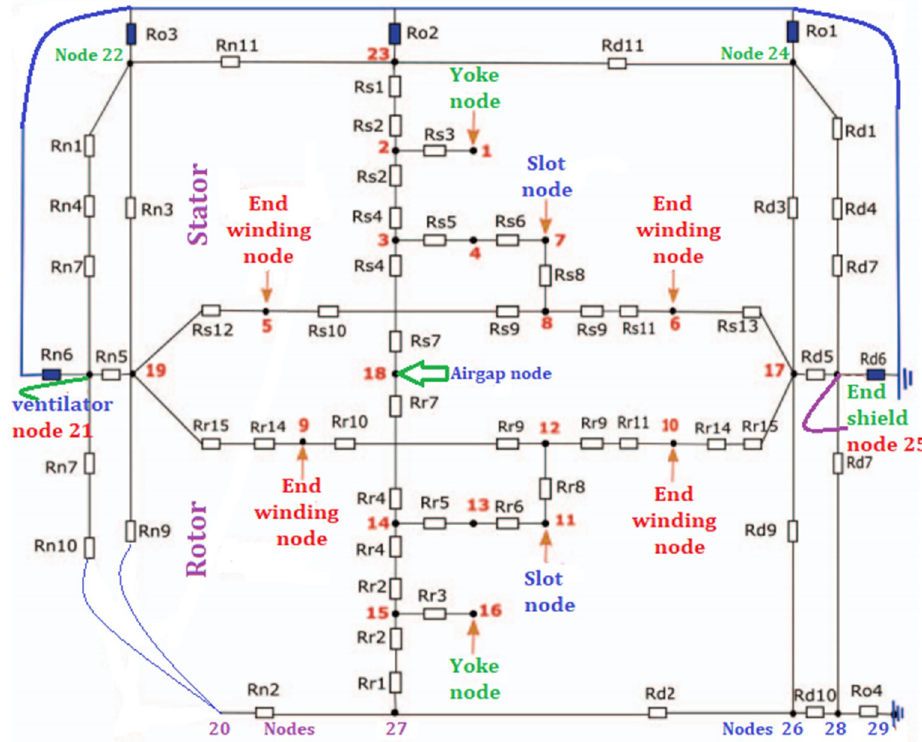
Figure 3. Example of an LPTN model of a 37 kW IM [20].